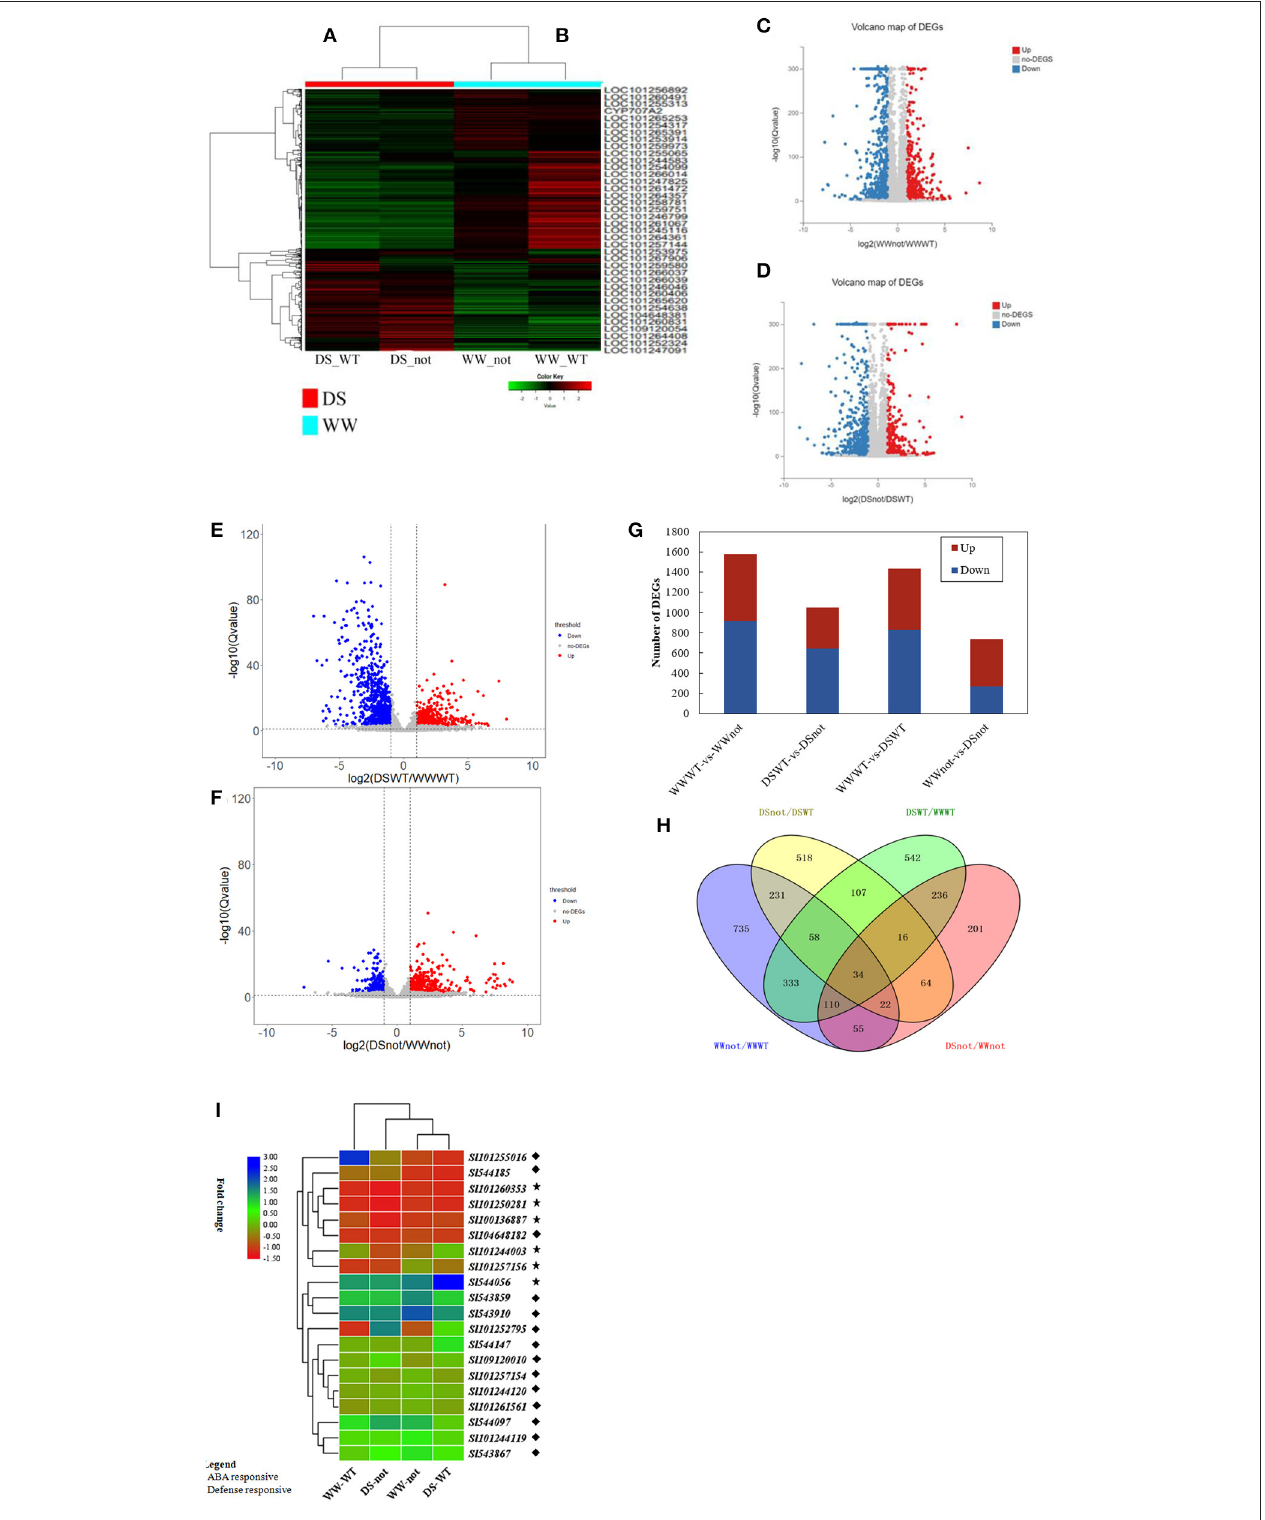
FIGURE 3 | Transcriptional variation in differentially expressed genes of tomato wild-type (WT) and mutant (not) responsive to drying stress and heatmap of DEGs compared under DS-WT and DS-not (A) ; WW-WT and WW-not (B) , based on the expression levels (RPKM + 1). Genes in red and green represent highly and